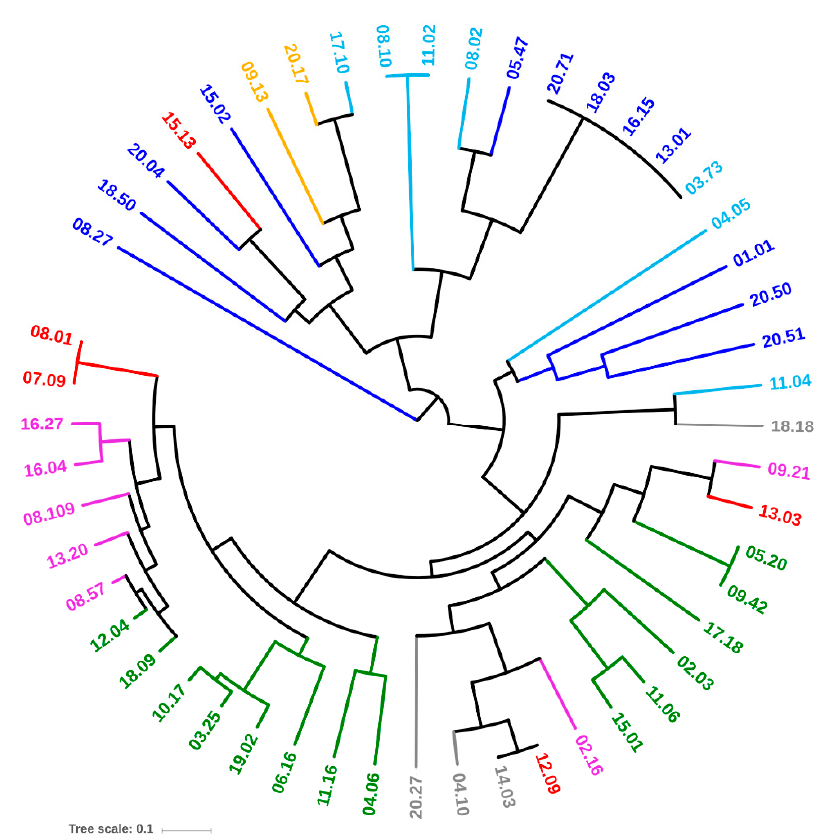
Figure 4. UPGMA dendrogram of E. coli strains, computed from Dice’s distance matrix of the virulence determinants. Strains are colored based on their phylogroups: A, cyan; B1, blue; B2, green; C, yellow; D, red; E, grey; F, pink.